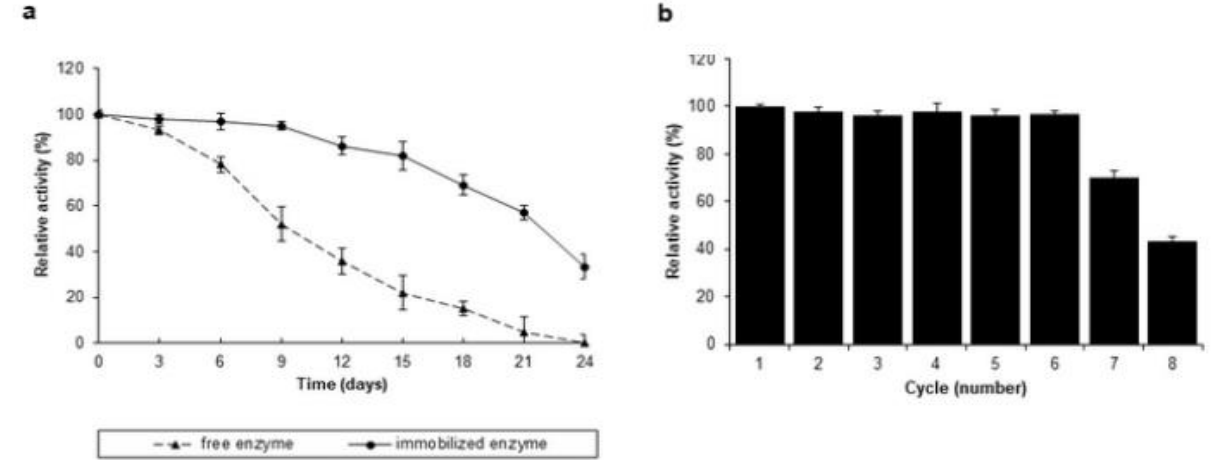
Figure 10. ( a ) Storage stabilities of Tt LacA in copper alginate beads. Storage stabilities at 4 °C in glycine-HCl buffer (pH 3.0) values for free ( ▲ , dotted line) and immobilized (●, continuous line) Tt LacA in copper alginate gel beads. The laccase activity was assayed under optimal conditions. ( b )